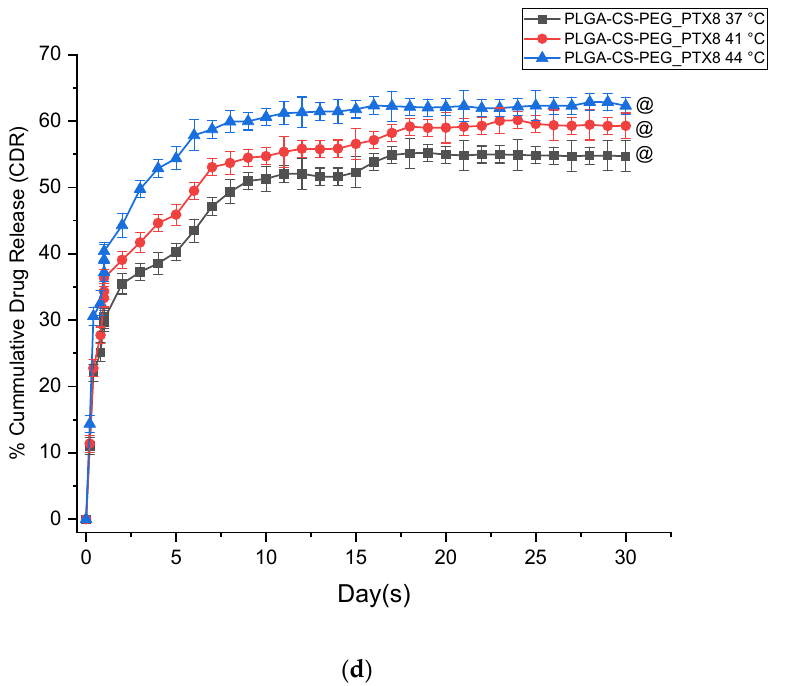
Figure 4. In vitro drug release profile of drug-loaded PLGA-CS-PEG microspheres: ( a ) PLGA-CS-PEG_PGS5, ( b ) PLGA-CS-PEG_PGS8, ( c ) PLGA-CS-PEG_PTX5, and ( d ) PLGA-CS-PEG_PTX8 performed in phosphate-buffered saline (pH = 7.4, 0.01% Tween 80) at set temperatures (37, 41, and 44 ◦ C). In all cases ( n = 3, @ p > 0.05). Error bars represent the standard deviation for n = 3. Table 3. Parameters for in vitro drug release from PLGA-CS-PEG microspheres as a function of time and temperature. Data are mean ± SD, n =